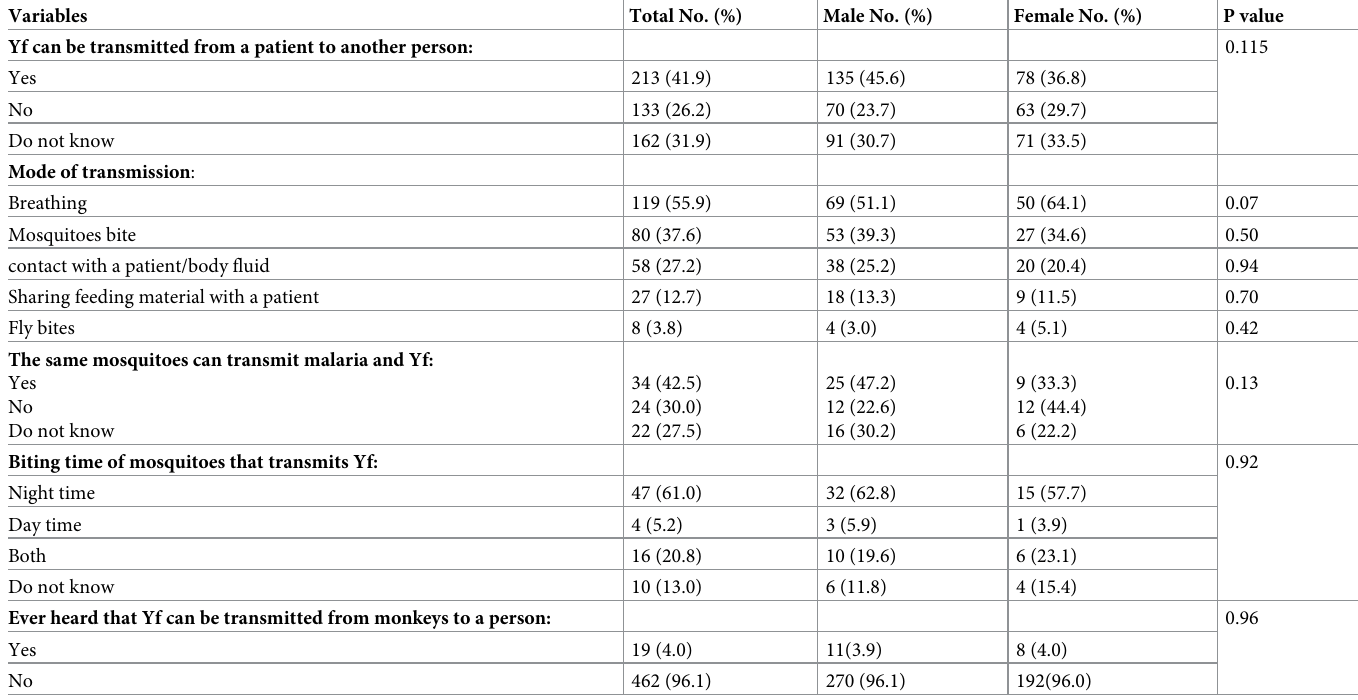
Table 3. Community’s knowledge regarding mode of transmission of